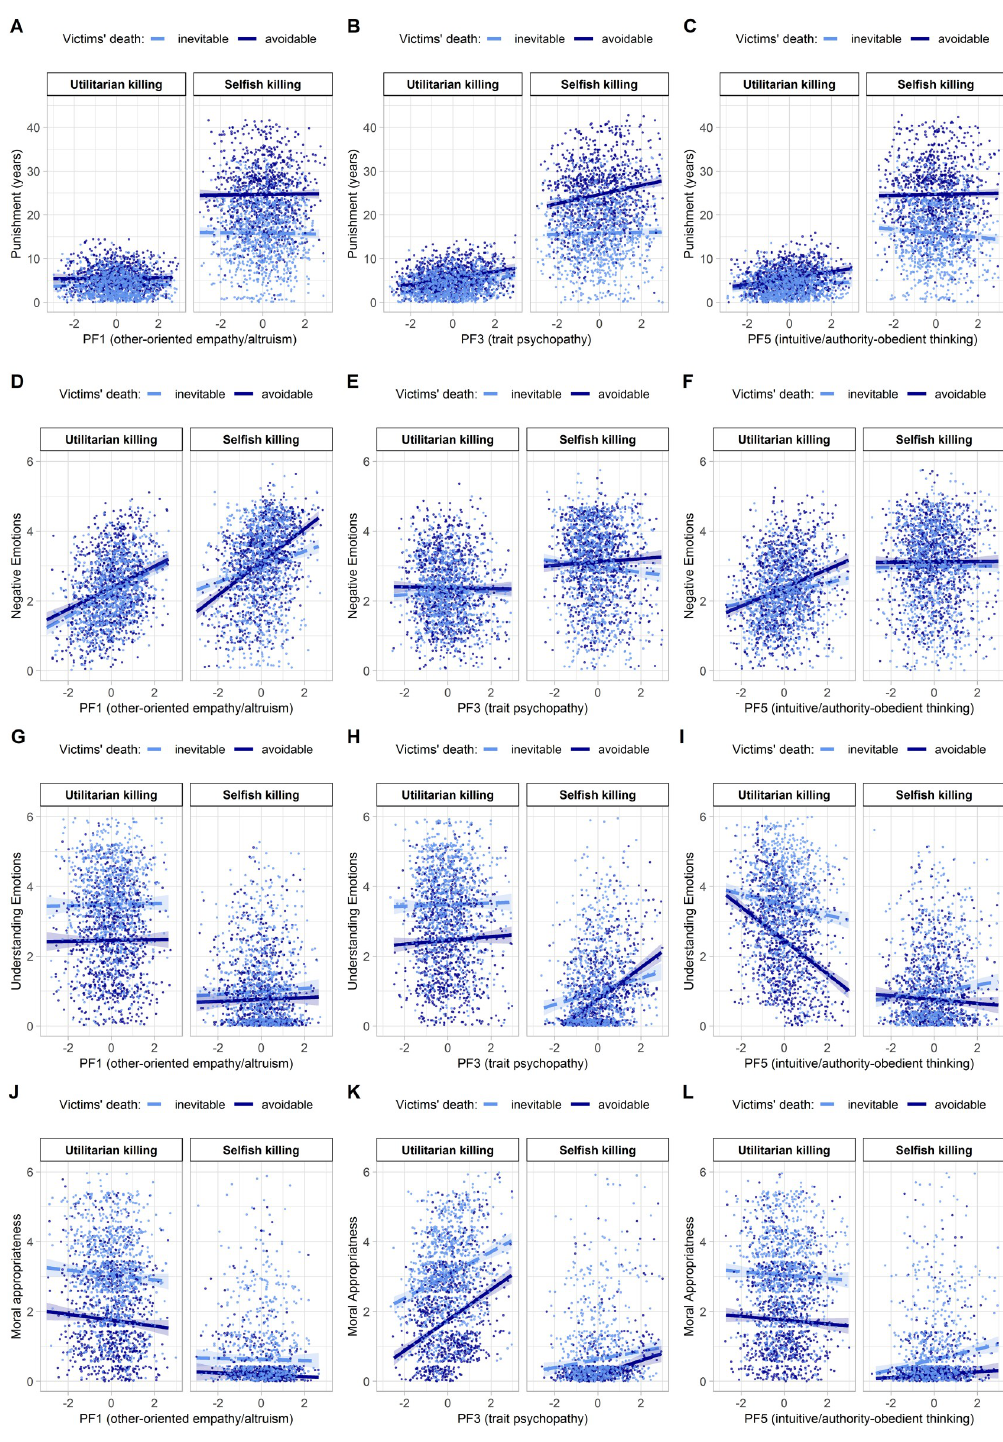
Fig 2. Influence of observer personality factors. On (A–C) the assigned punishments, the observers’ (D–F) negative emotions and (G–I) understanding emotions towards perpetrators, and (J–L) the moral appropriateness rated by observers.